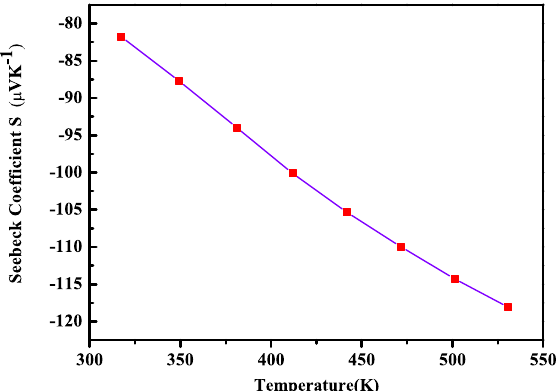
Figure 9. Temperature dependence of the Seebeck coefficient S